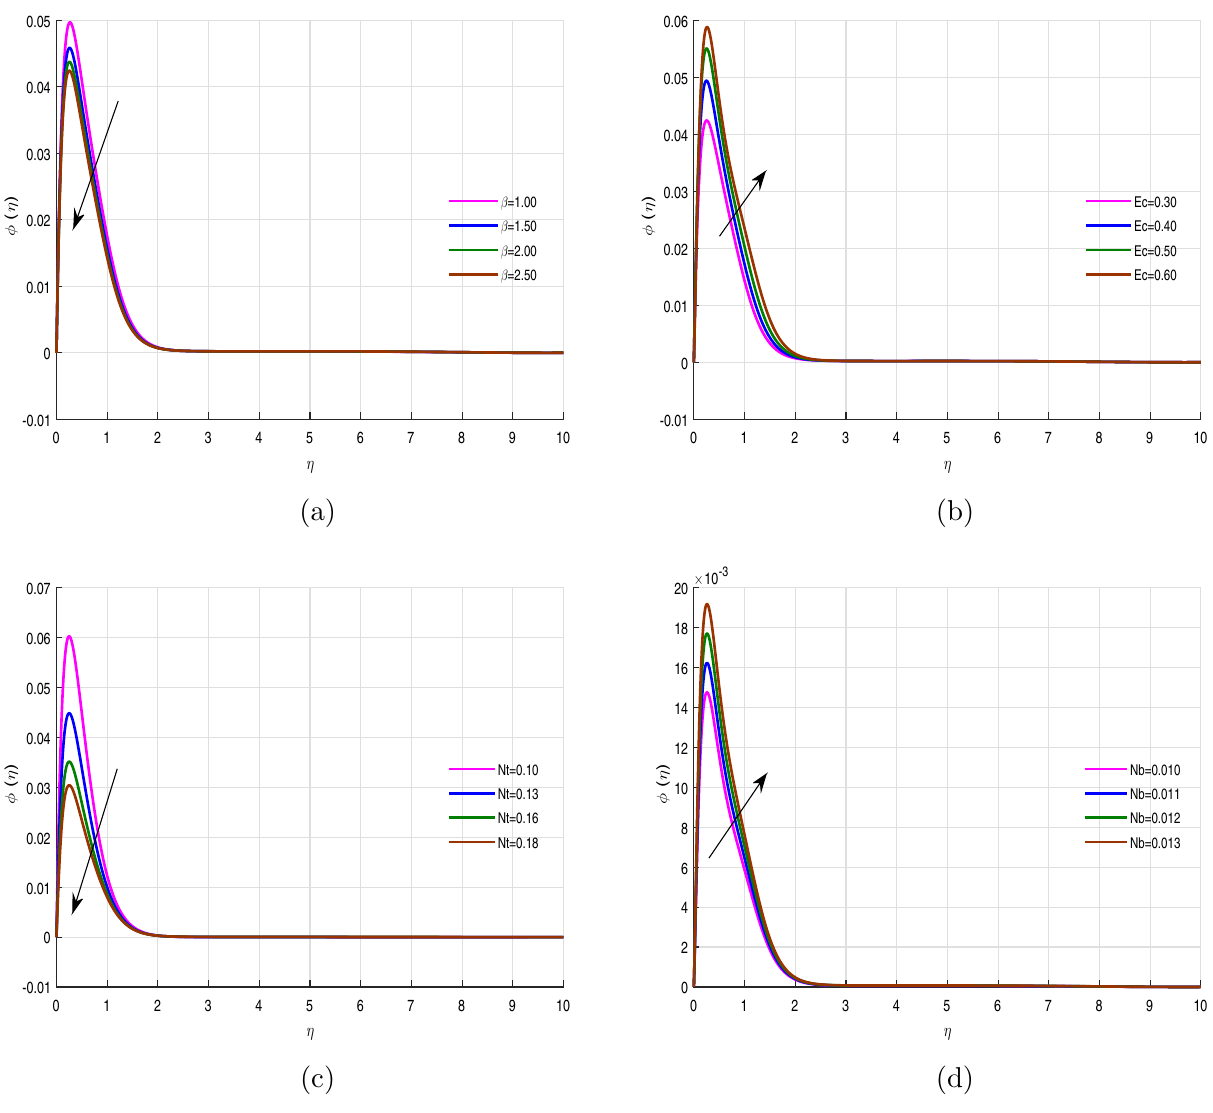
Figure 2. Concentration profile φ(η) for fixed values of physical parameters (cid:31) = 0.1 k = 8.933 , Pr = 6.0 , M = 0.5 , Gr = 0.09 , Gc = 0.05 , σ 1 = 1.1 , σ 2 = 10.9 , R = 0.5 , Ec = 0.6 , Nb = 0.01 , Nt = 0.1 Sc = 9.0 , fw = 1.0 , ϕ = 0.2 , n = 0.01 and β = 2.5